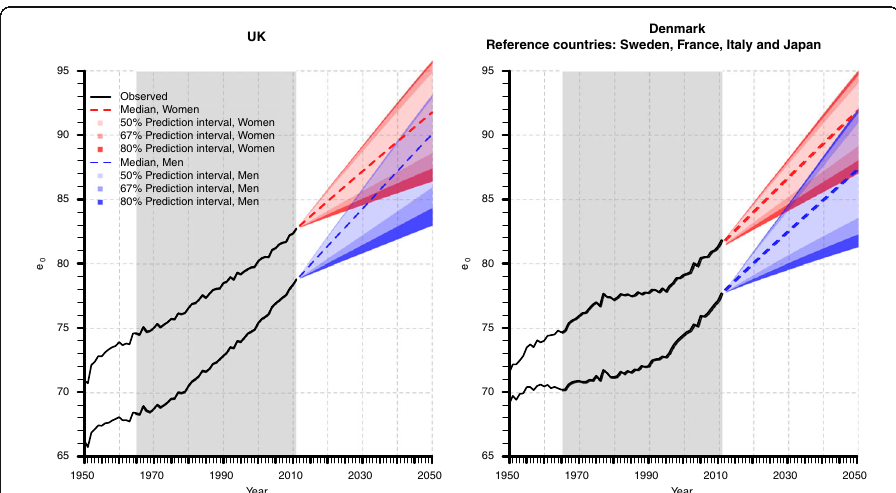
Fig. 4 Observed ( black ) and forecasted life expectancy at birth ( e 0 ) of our model for British ( left ) and Danish ( right ) women ( red ) and men ( blue ); increasing forecast uncertainty is represented by the widening 80, 67, and 50% prediction intervals, whose colors become brighter from the outside to the median ( dashed line ). We forecast mortality from 2012 to 2050 given data from 1965 to 2011 ( gray colored box ). Moreover, in the Danish forecasts, we combine the mortality trends of Denmark, France, Italy, and